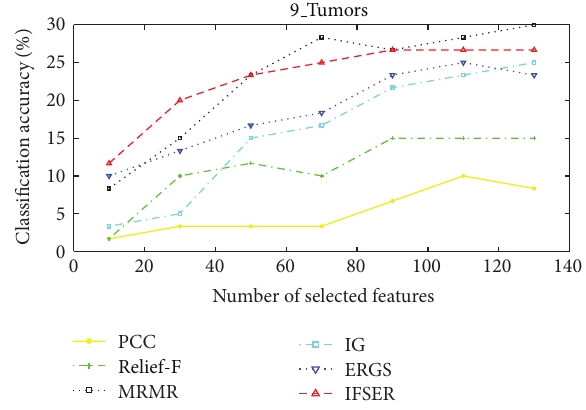
Figure 6: The classification accuracies of different algorithms on the 9 Tumors